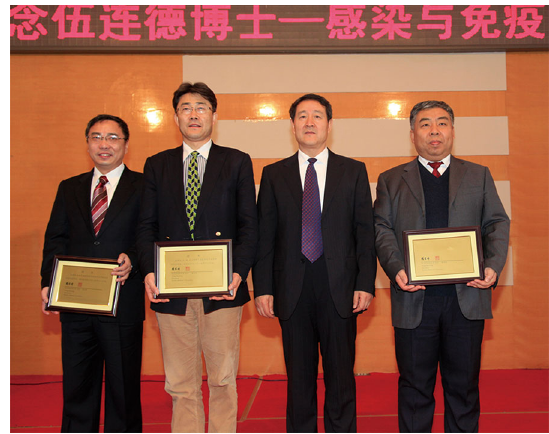
Figure 3. Wu Lien-Teh Institute was opened on Dec 24th, 2015 in Harbin. President of the Institute is Dr George Fu Gao (The 2nd from